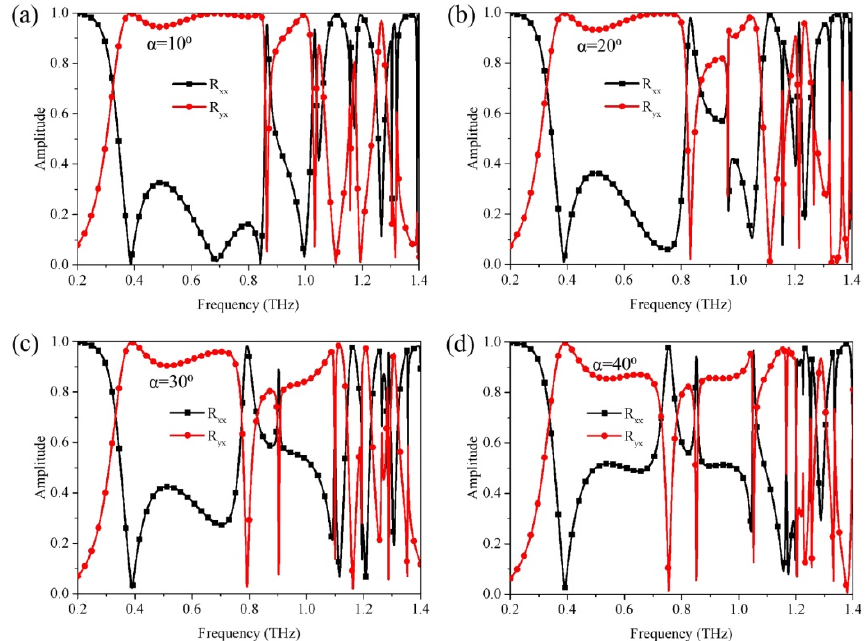
Figure 6. The reflection spectra of the designed metasurface vary with the incident angle for the linear polarization incidence. ( a ) α = 10°, ( b ) α = 20°, ( c ) α = 30°, ( d ) α = 40°.